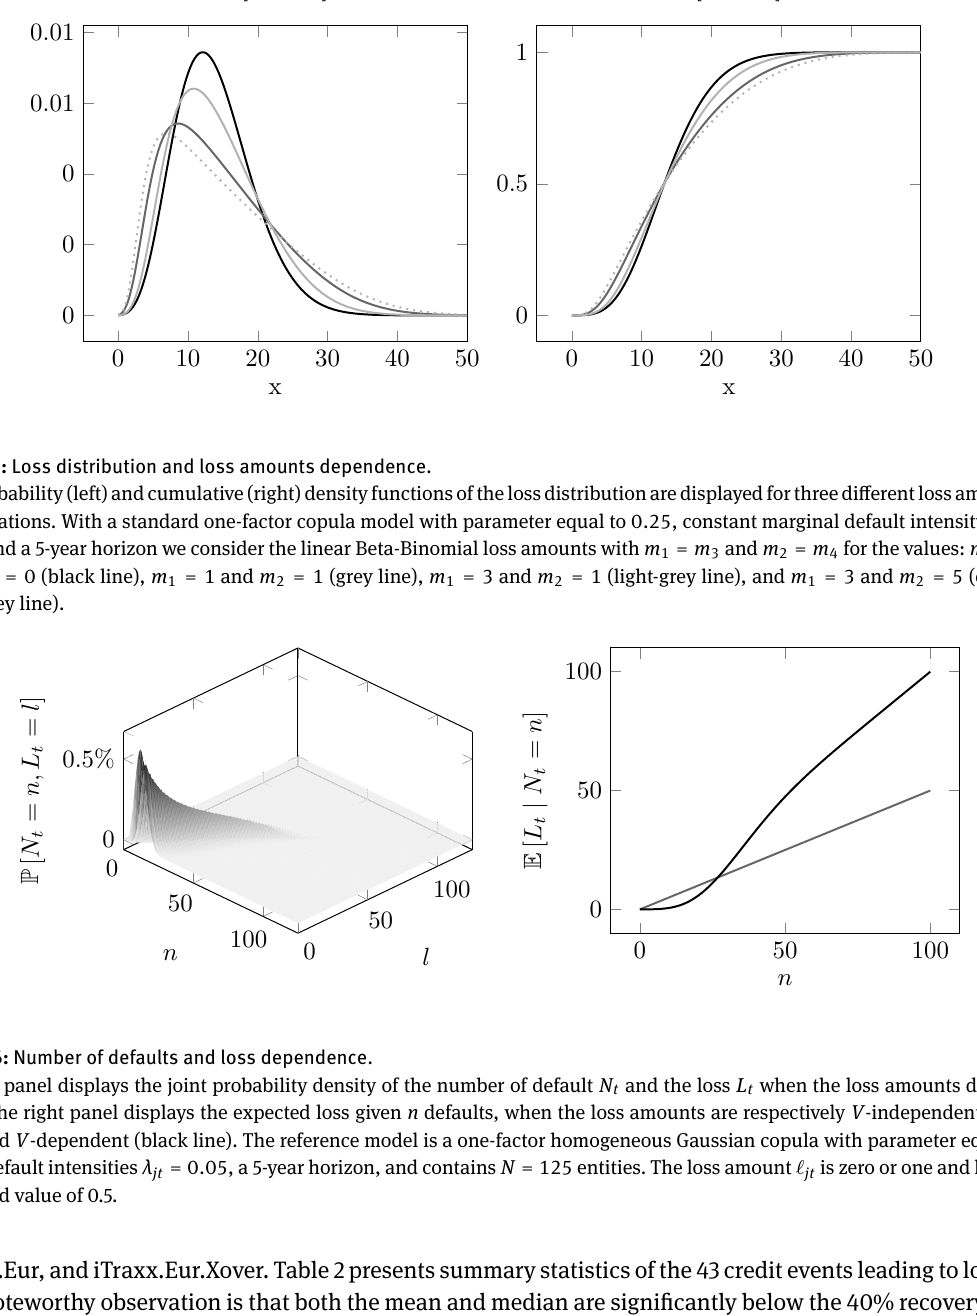
and the loss L when the loss amounts depend t t is zero or one and has an jt